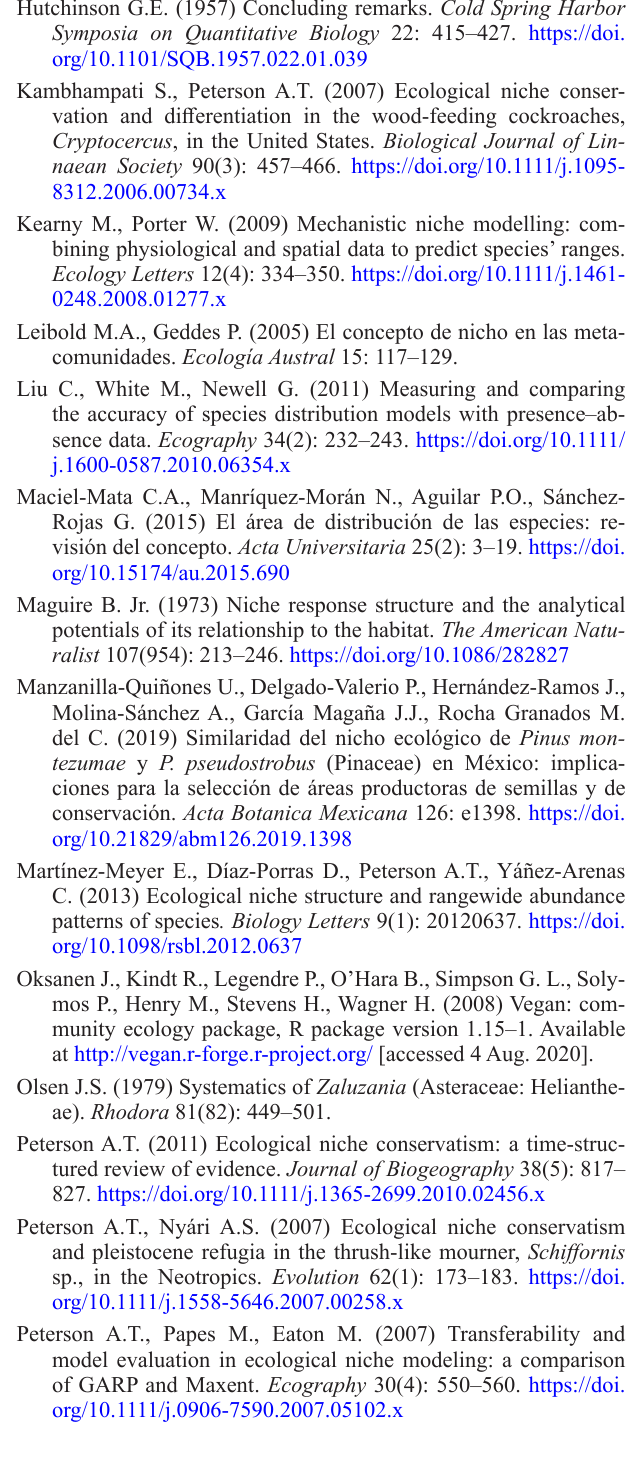
Supplementary file 2: List of variables used in the niche models of the analysed